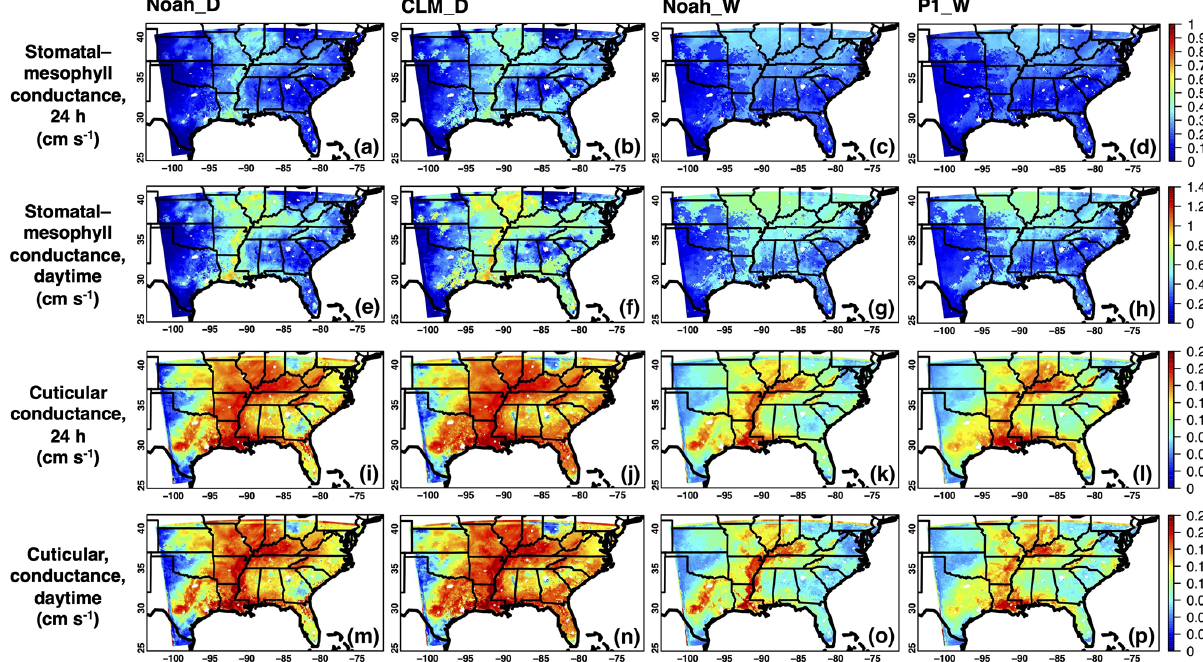
Figure 8. Period-mean (16–28 August 2016) WRF-Chem (a–h) stomatal–mesophyll and (i–p) cuticular conductances over terrestrial regions that do not belong to the urban category in Fig. 1a. Results are shown for (a, e, i, m) Noah_D, (b, f, j, n) CLM_D, (c, g, k, o) Noah_W, and